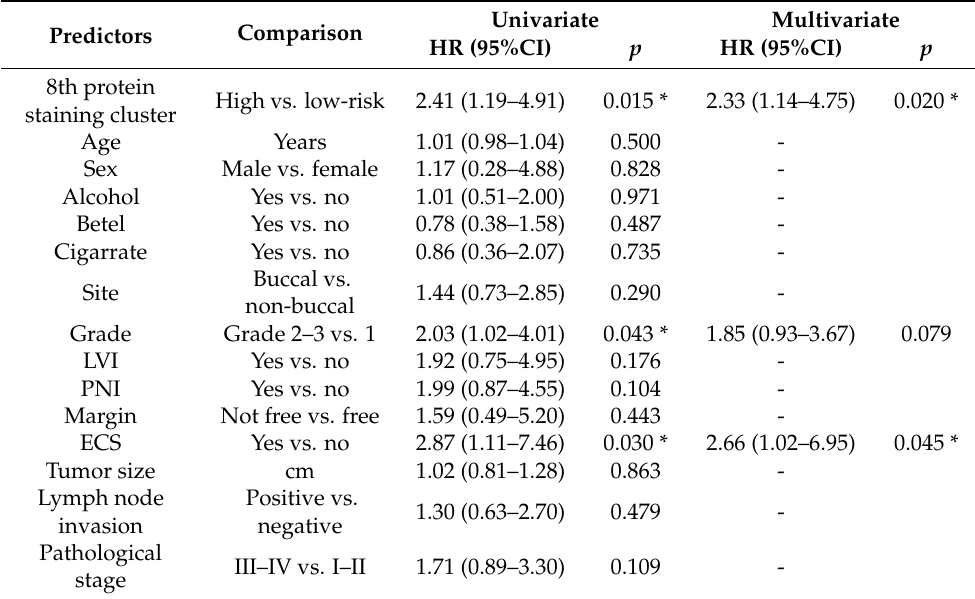
Table 3. Cox proportional hazard regression analysis of progression-free survival.